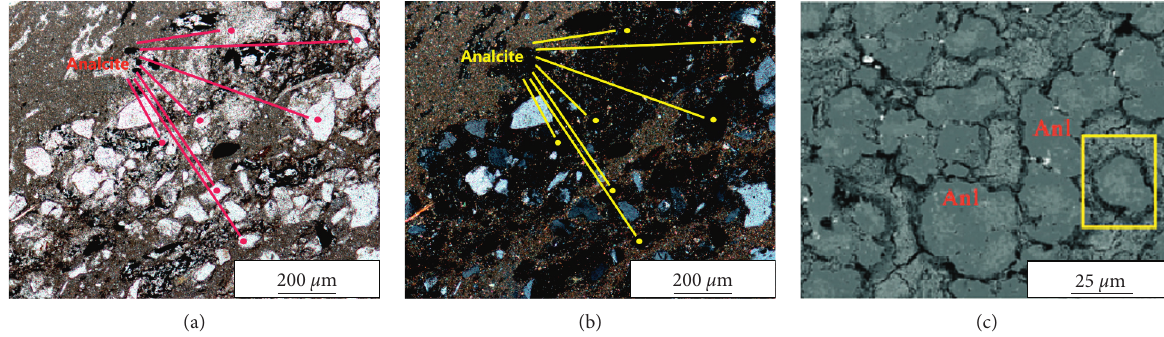
Figure 9: Analcime transformed from feldspar. (a, b) Analcime formed by conversion of K-feldspar. (c) The metasomatism remnant orthoclase can be seen inside the analcime [20].